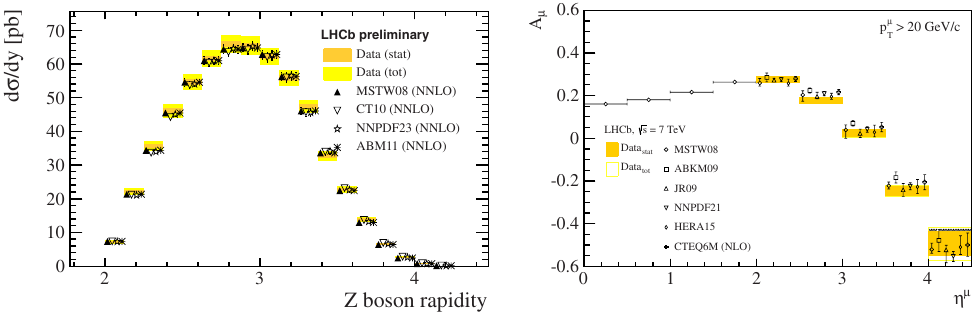
Figure 4. Differential cross-section for Z production in bins of boson rapidity (left) and W charge asymmetry in bins of lepton pseudo-rapidity (right) compared to theoretical